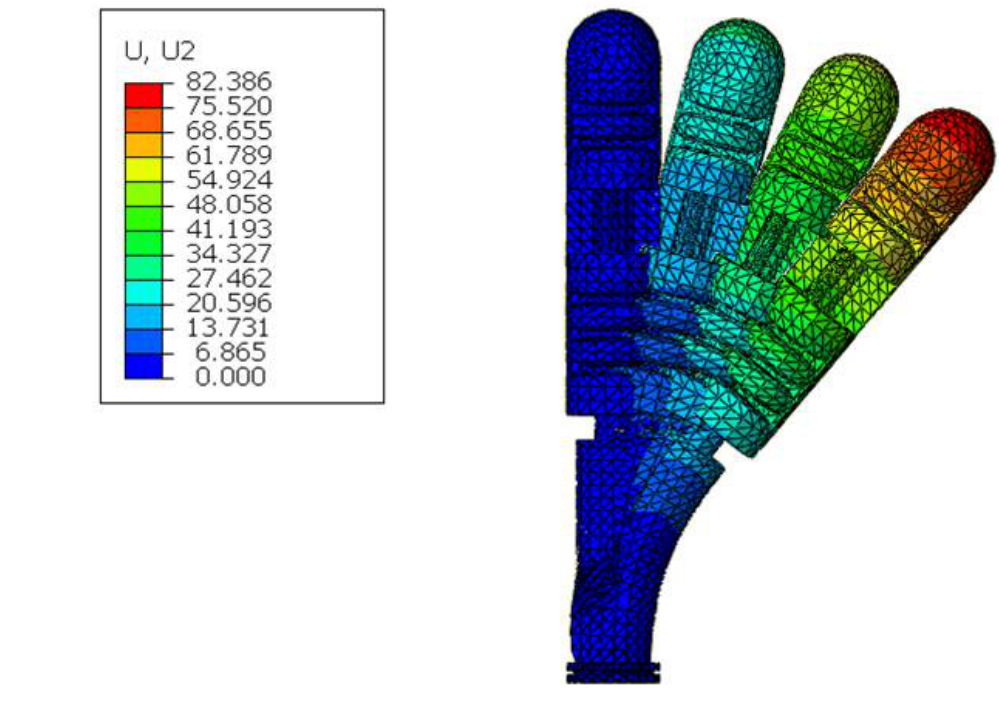
Figure 8. Proximal phalangeal joint curved shape.